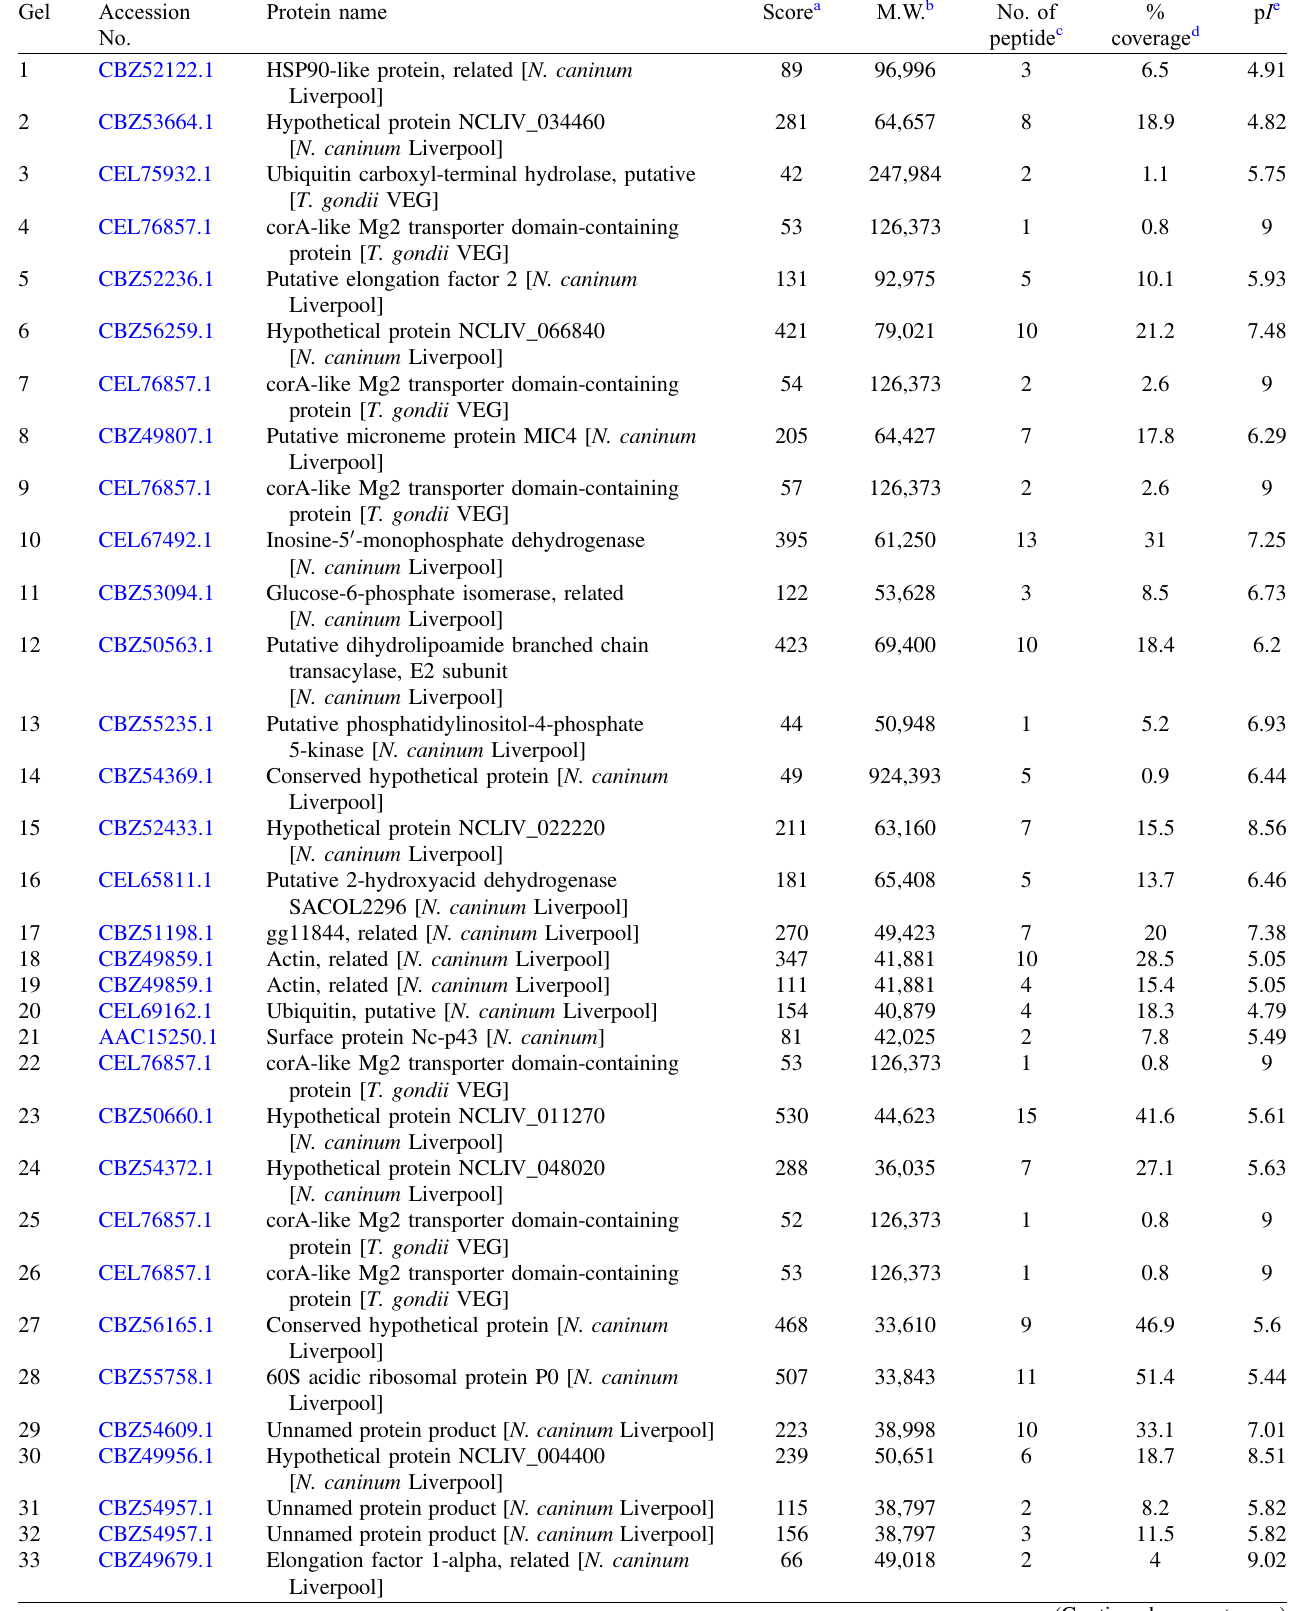
Table 2. List of proteins identi fi ed on the 2-DE pro fi les of Neospora caninum (Nc-1) tachyzoites probed with known bovine sera analysed by mass spectrometry